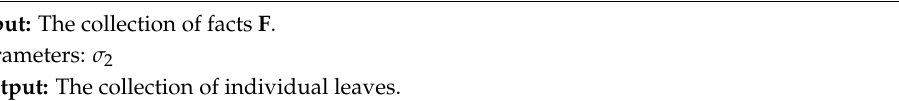
Algorithm 3 Facet region growing.